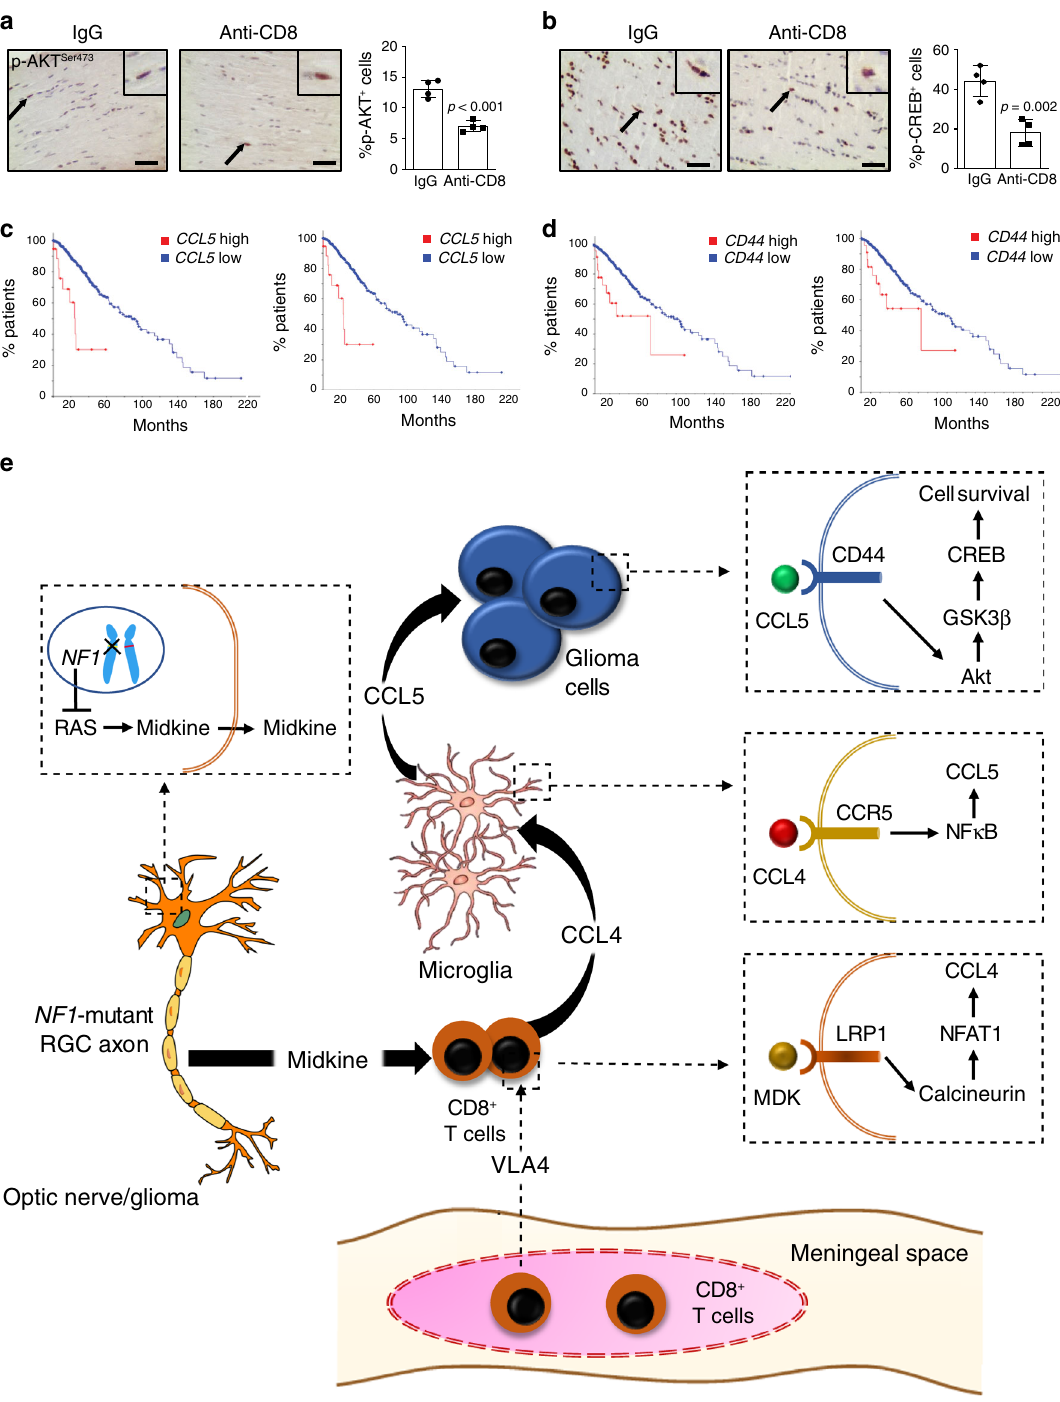
Fig. 8 T cell-induced Ccl5/CD44-mediated cell survival underlies Nf1 optic glioma growth. a , b Immunohistochemistry revealed that anti-CD8 antibody treatment reduced the percentage of p-AKT Ser473 -expressing and p-CREB Ser133 -expressing cells in mouse Nf1 optic glioma specimens. Black arrows denote representative immunopositive cells. Scale bars, 20 µ m. Bar graphs represent the means ± SEM of n = 4 independent biological samples. Two-tailed Students- t test. Exact P values are indicated within each panel; a P < 0.001; b P = 0.002. c , d Kaplan – Meier survival curves (Brain Lower Grade Glioma TCGA Provisional [2 left panels; c P = 1.29e − 6, d P = 2.06e − 3] and TCGA PanCancer Atlas [2 right panels; c P = 4.69e − 13, d P = 9.86e − 3]